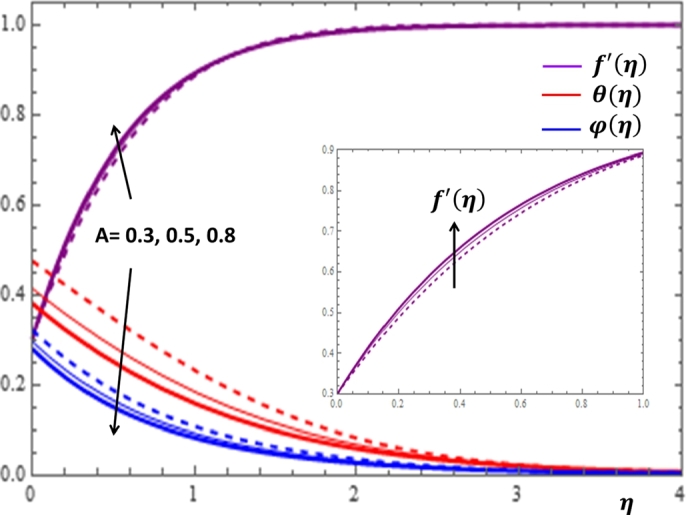
Impacts of the unsteadiness parameter on f′(η), θ(η) and φ(η).